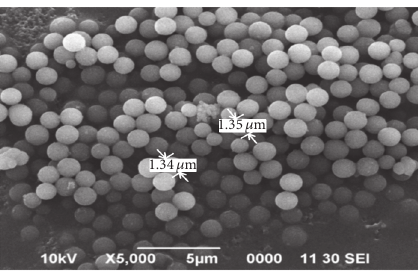
Figure 2: SEM image of imprinted polymer.